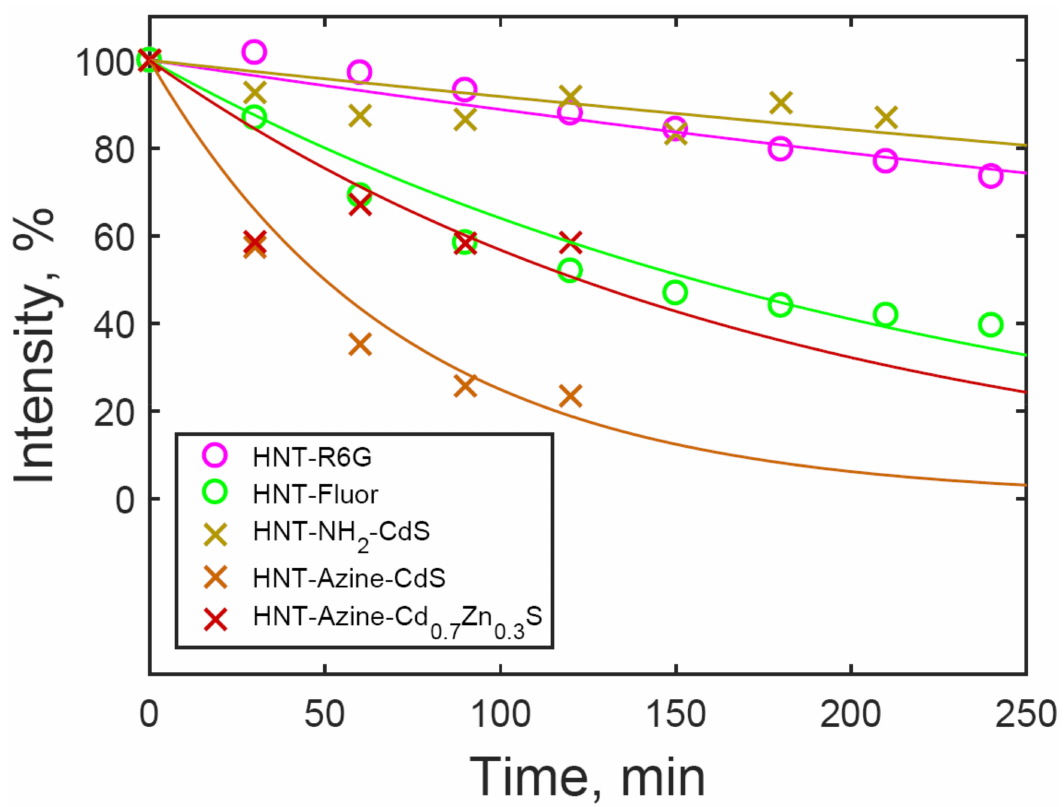
Figure 5. Time-dependent luminescence intensity of the synthesized materials (lines are first-order kinetics fits; see also Table S2 in Supplementary